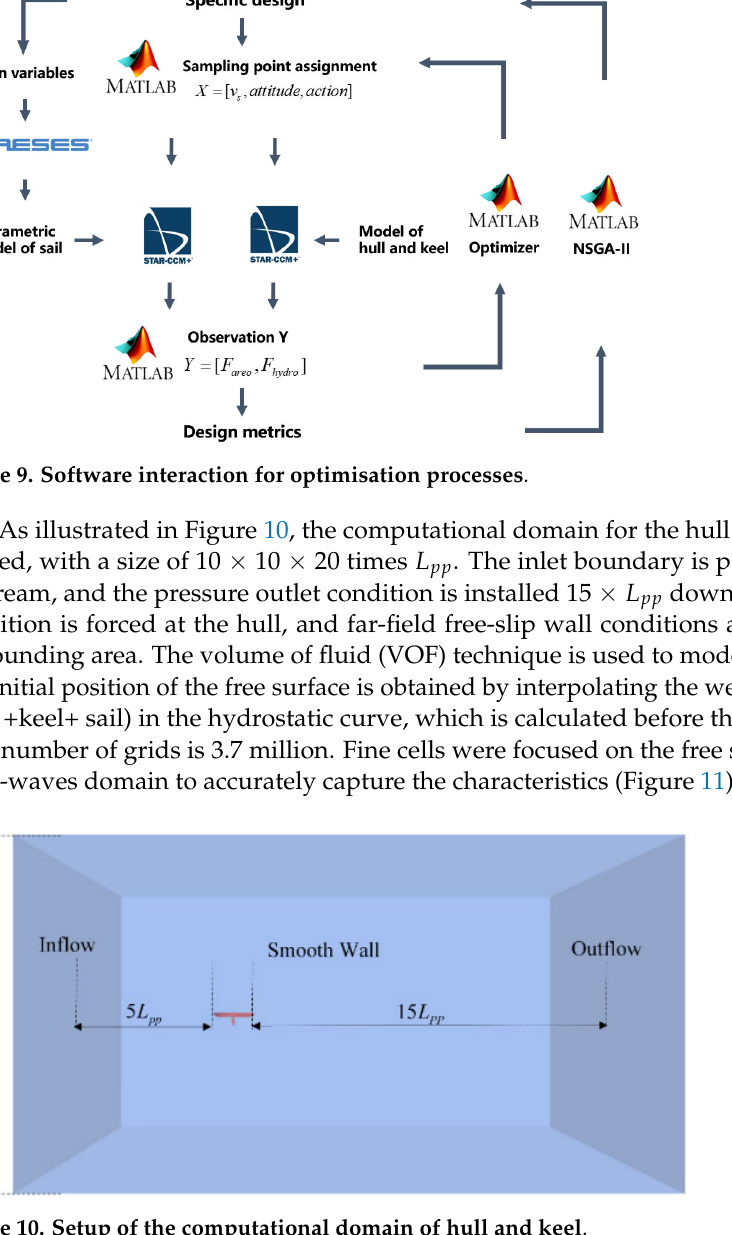
Figure 10. Setup of the computational domain of hull and keel.